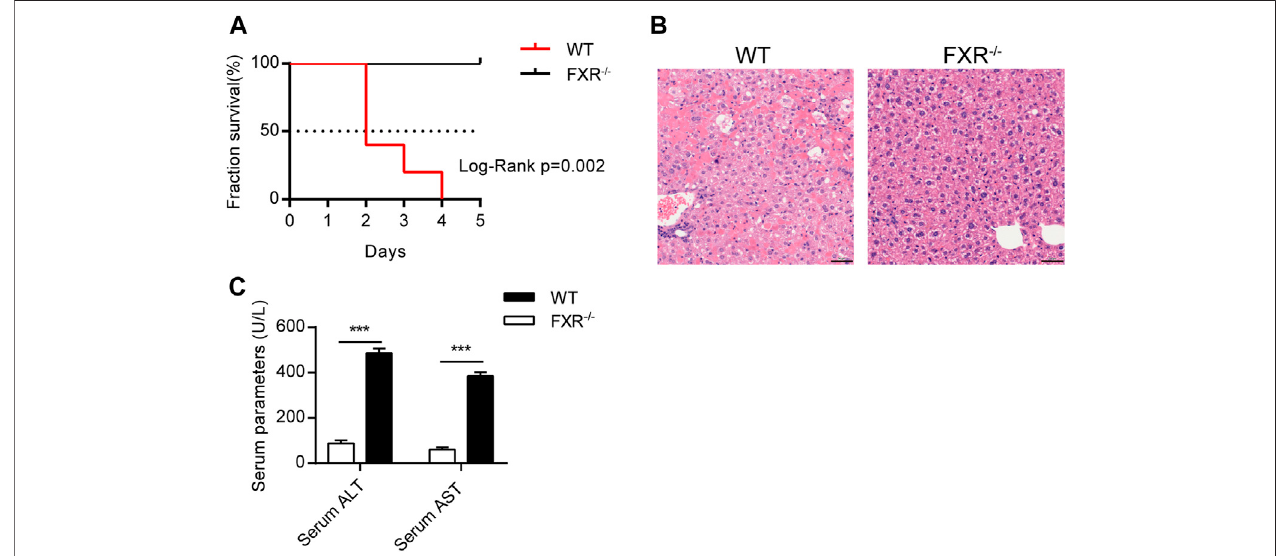
FIGURE1| Over-doseOCAreducedsurvivalandpromotedhepaticinjuryinanFXR-dependentmanner.Wild-type(WT)andFXR − / − miceweregivenahighdoseof OCA(0.40%OCAincorporatedintoahigh-fatdiet)for5days(n=5). (A) SurvivalofWTandFXR − / − mice;Log-Rank p =0.002;HR=26.85,95%CI(3.50,205.70). (B) HE stainingofliversections fromWT mice and FXR − / − mice. (C) Serum alanineaminotransferase (ALT)and serum aspartate aminotransferase(AST) ofWTmice and FXR − / − mice. ns, not signi fi cant; *, p ＜ 0.05; **, p ＜ 0.01; ***, p ＜